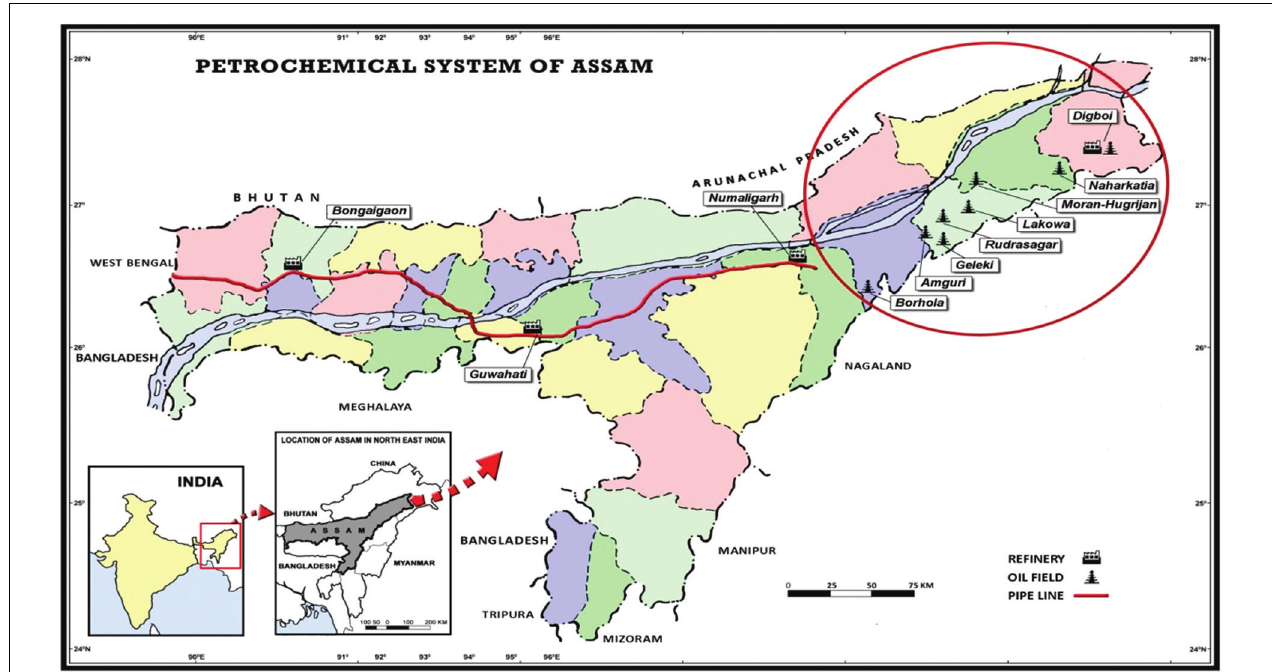
FIGURE 1 | Map of petrochemical system of state Assam, India highlighting different oilfields, refineries and pipelines.